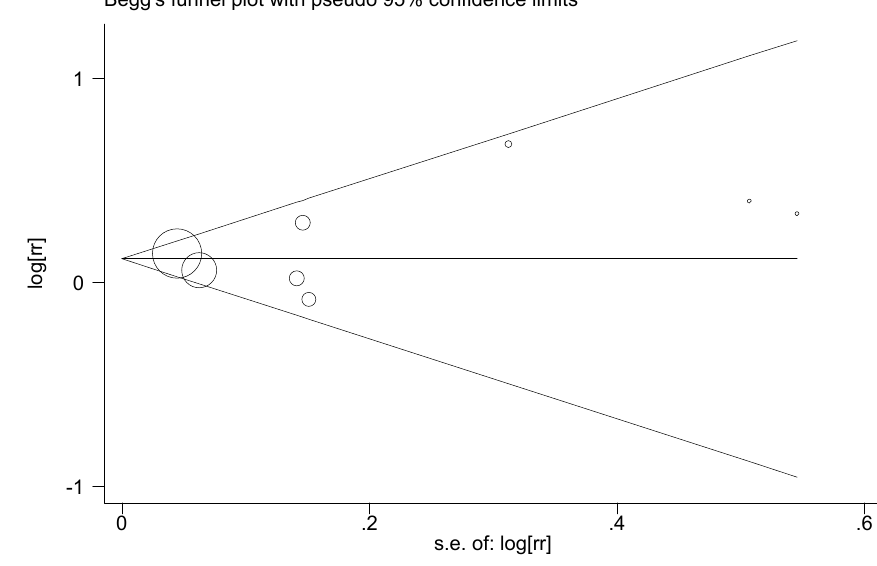
Figure 4. Funnel plot for assessing publication bias risk in the meta-analysis.